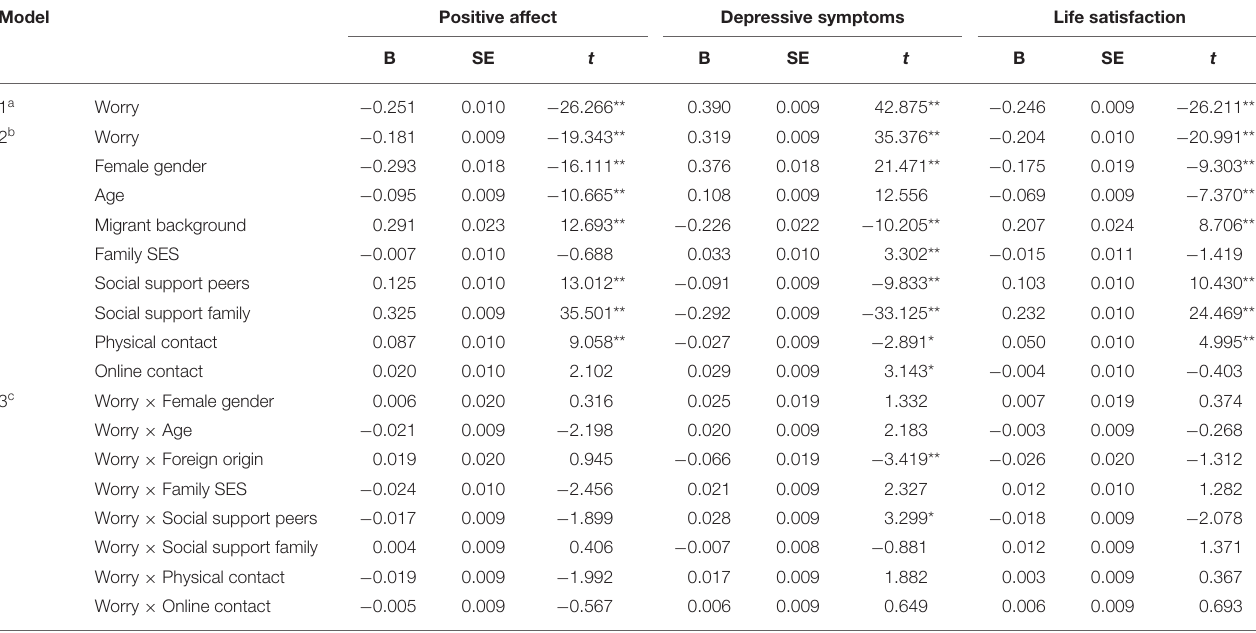
TABLE 3 | Regression analyses for the association between worries about COVID-19’s academic and economic consequences on adolescents’ mental health and life satisfaction.